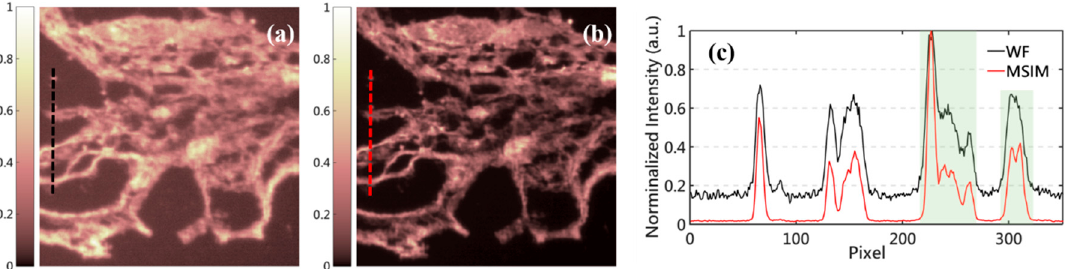
Figure 8. Results of the fixed partial transverse section of earthworm (dehydration structure of body cavity fluid) by WF microscopy ( a ) and MSIM ( b ). ( c ) Intensity profiles along the colored dash lines in ( a , b ), respectively. Scale bars: 40 μ m.